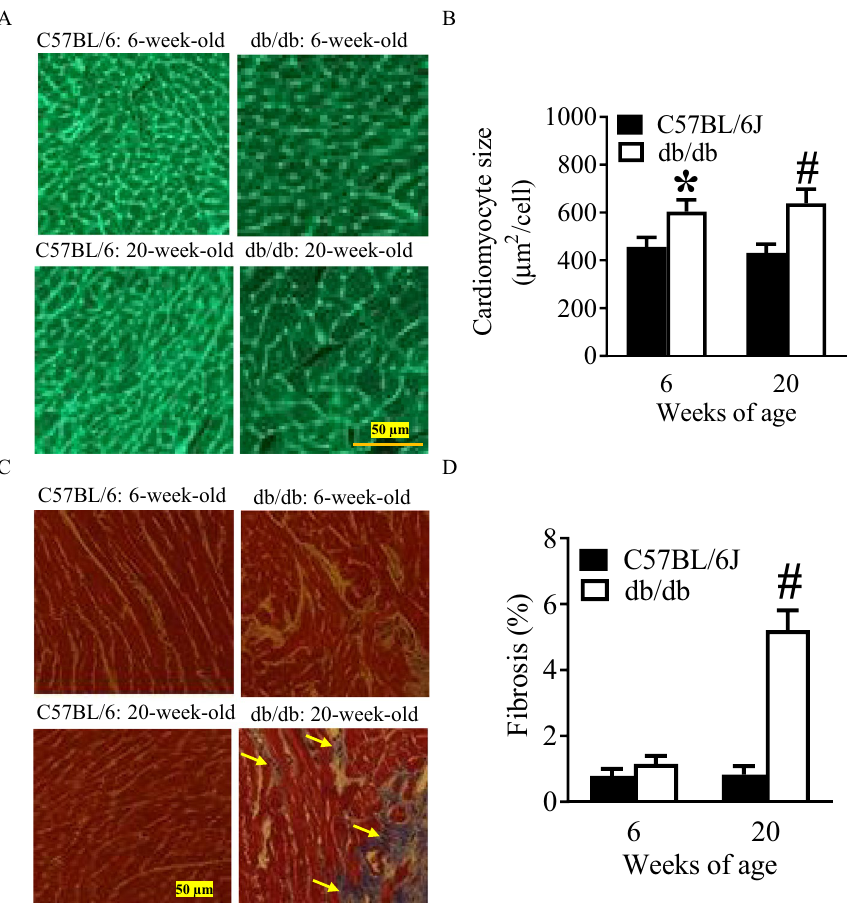
Figure 1. Histopathological analysis of the hearts of C57BL/6J and db/db mice at 6 and 20 weeks of age. (A) Representative photomicrographs of mouse hearts following a wheat germ agglutinin staining; (B) quantification of cardiomyocyte size; (C) representative photomicrographs of mouse hearts following a Masson’s trichrome staining; (D) quantification of myocardial fibrosis. Wheat germ agglutinin ( A , B ) and Masson’s trichrome ( C,D ) were used to stain left ventricular sections of C57BL/6J and db/db mice. In Masson’s trichrome staining, interstitial fibrosis was stained in blue, as indicated by yellow arrows, and ventricular muscle was stained in red. The scale bar represents 50 µm. *P < 0.05 versus C57BL/6J group at 6 weeks old; # P < 0.05 versus C57BL/6J group at 20 weeks old (n =